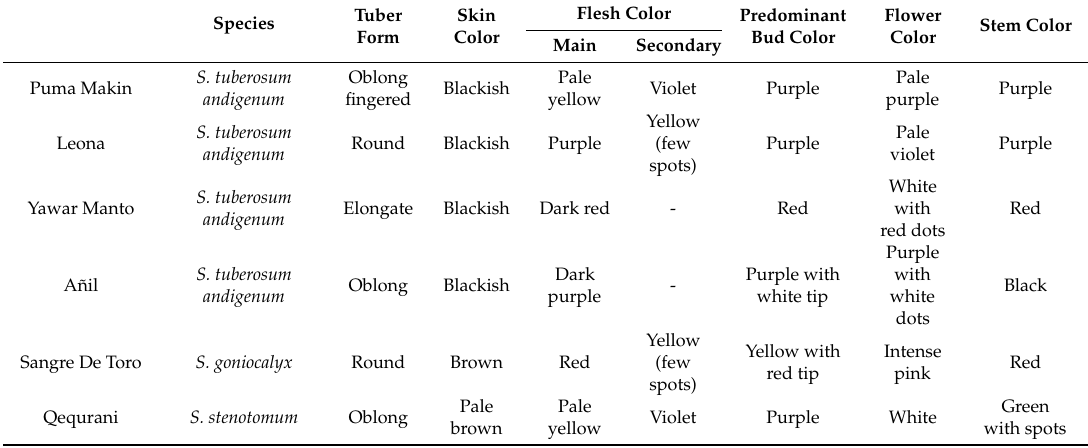
Figure 1. Varieties of Andean potatoes—Puma Makin, Leona (first line), Yawar Manto, Añil (second line), and Sangre de Toro, Qequrani (third line). Table 1. Main morphological characteristics of the studied accessions of Andean potatoes.